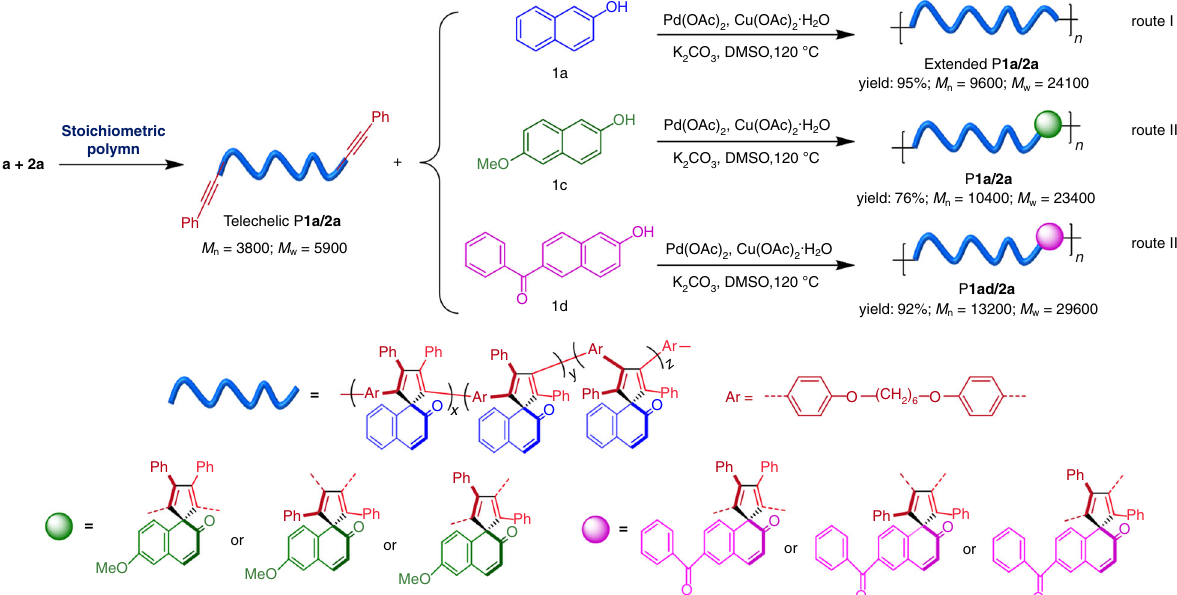
Fig. 3 Preparation and post-polymerization of telechelic polymer. The telechelic polymer P 1a / 2a is prepared at a monomer feed ratio of 1:1, and the polymerizations of telechelic P 1a / 2a with 1a (route I), 1c (route II), and 1d (route III) are conducted based on the apparent monomer-nonstoichiometry- promoted